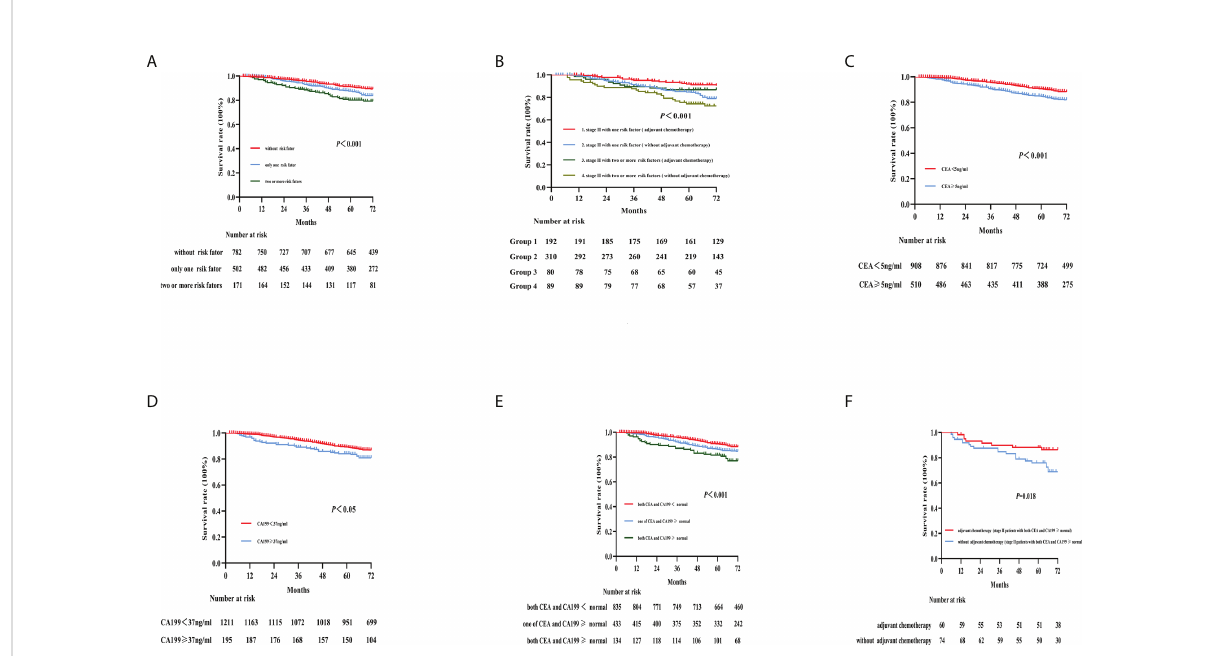
FIGURE 4 Kaplan – Meier curves for the survival analysis in stage II colon cancer patients. The fi gures show OS according to different risk factors (A) , adjuvant chemotherapy with different risk factors (B) , preoperative CEA and CA199 levels (C – E) , and adjuvant chemotherapy combined with elevated CEA and CA199 (F) . OS, overall survival; CEA, carcinoembryonic antigen; CA199, carbohydrate antigen